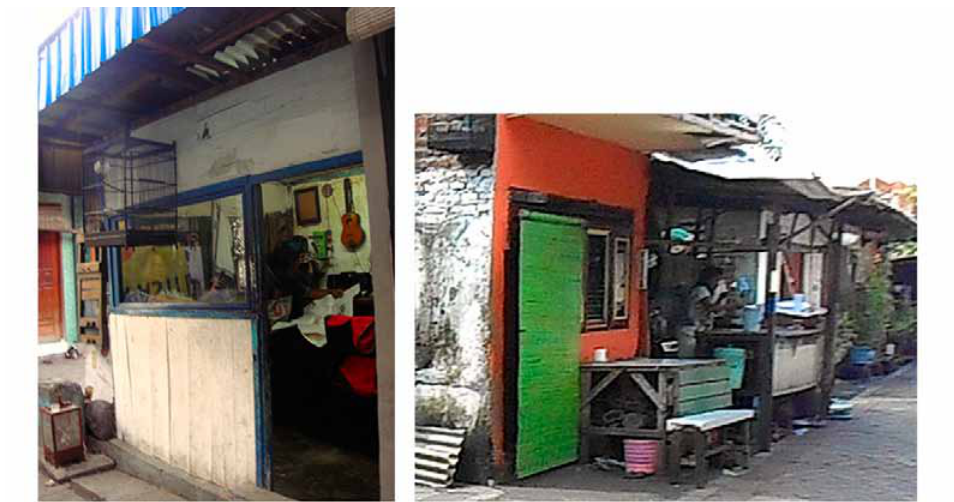
fig. 3. The favourite place to socialize in kampung Kedondong